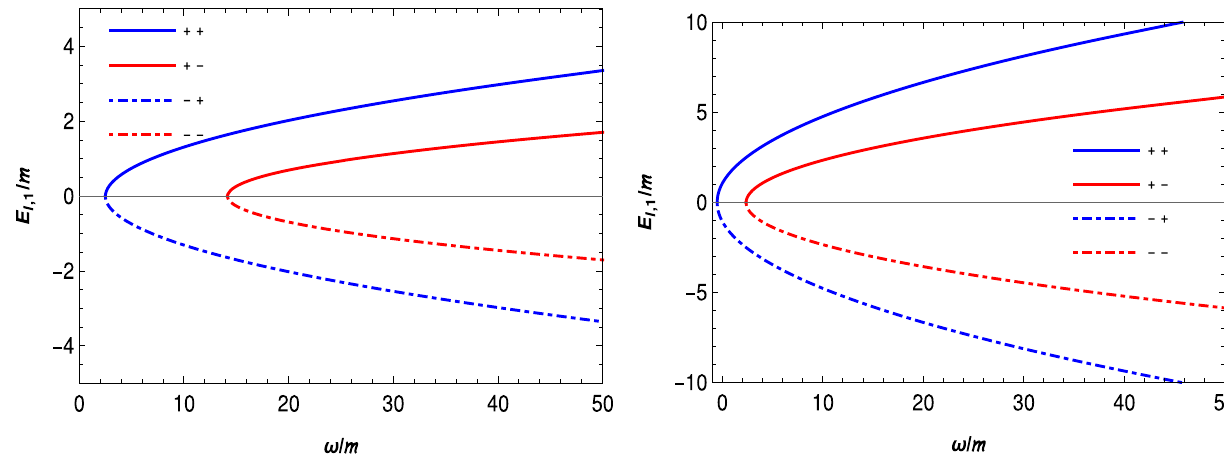
inside the root of Eq. (18). We fixed m 2 (cid:4) = l = 1 and also did α = 0 . 2. The dotted lines indicate the negative energy values. In the figure on the right, we carry out the same process now by varying the parameter α = 0 . 6